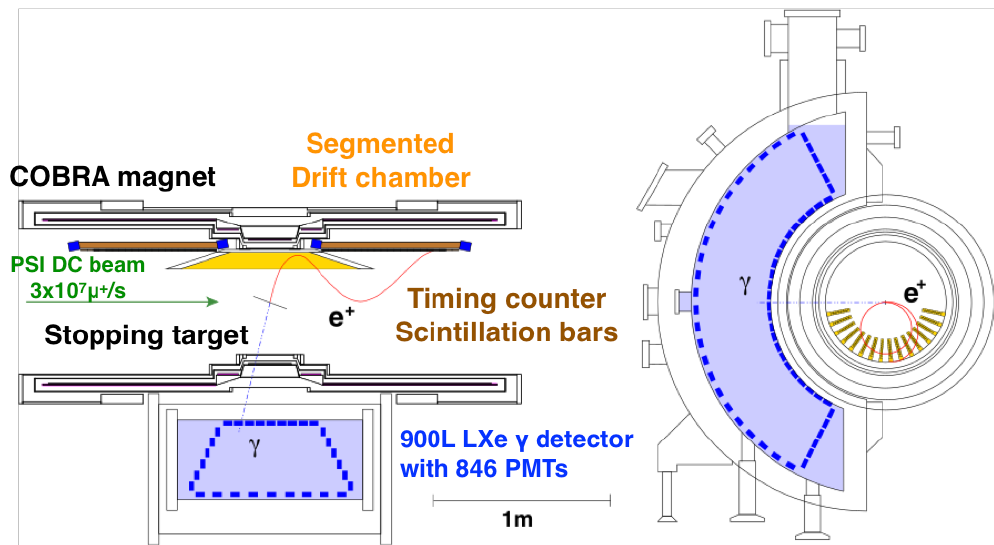
Figure 1: The schematic view of the MEG